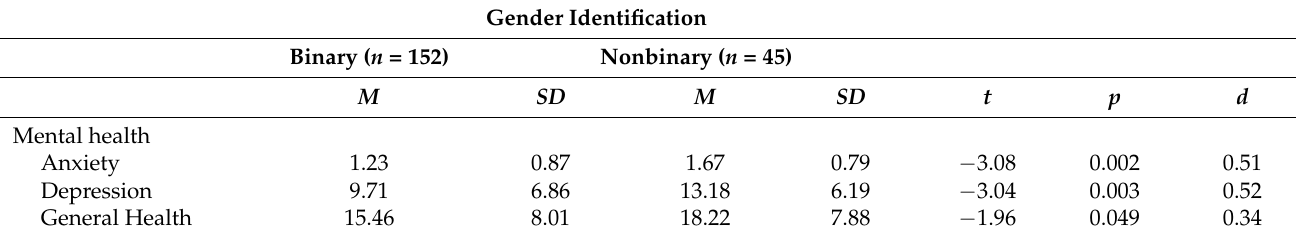
Table 6. Means comparisons of mental health outcomes based on gender